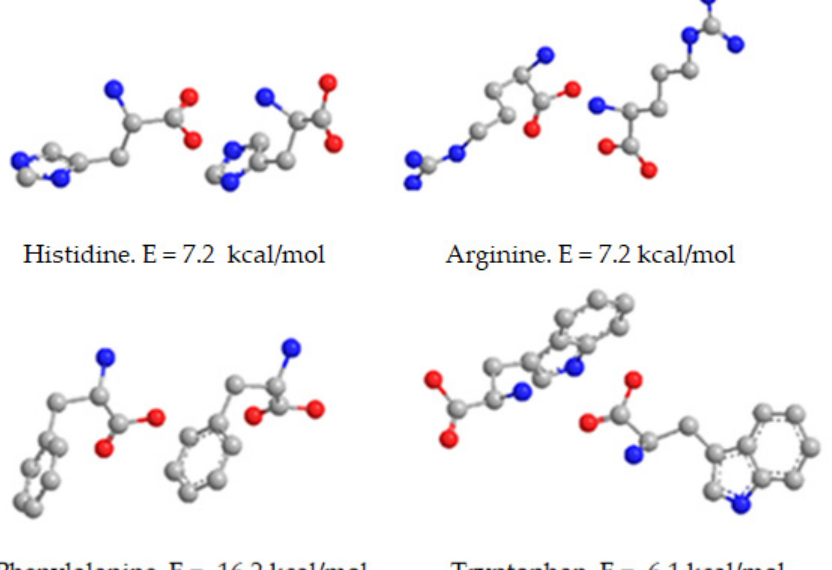
Figure 7. Energy content and most favorable spatial orientation of the dimers of proteinogenic amino acids (phenylalanine, tryptophan, histidine and arginine) computed by molecular mechanics. Light grey balls represent carbon atoms. Blue balls represent nitrogen atoms. Red balls represent oxygen atoms.